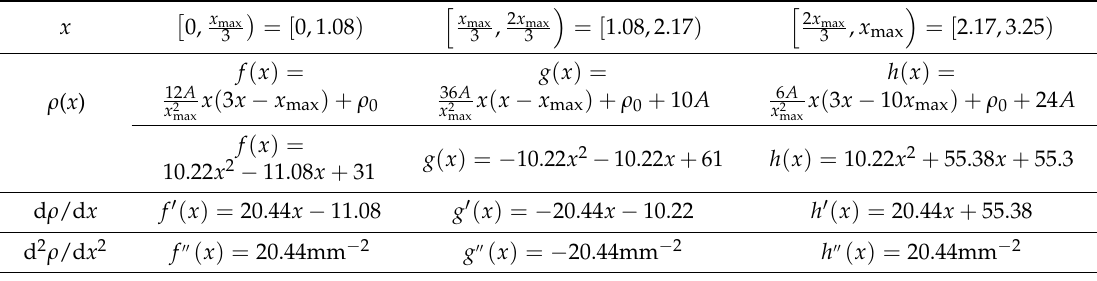
Table 6. Modeling of the reflection functions: Group H30—metal ceramic prostheses.